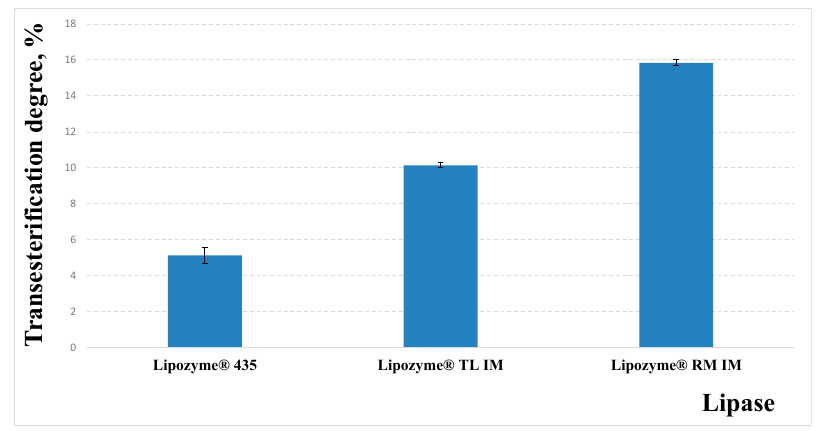
Figure 1. Dependence of transesterification degree on the species of lipases under the same process conditions.